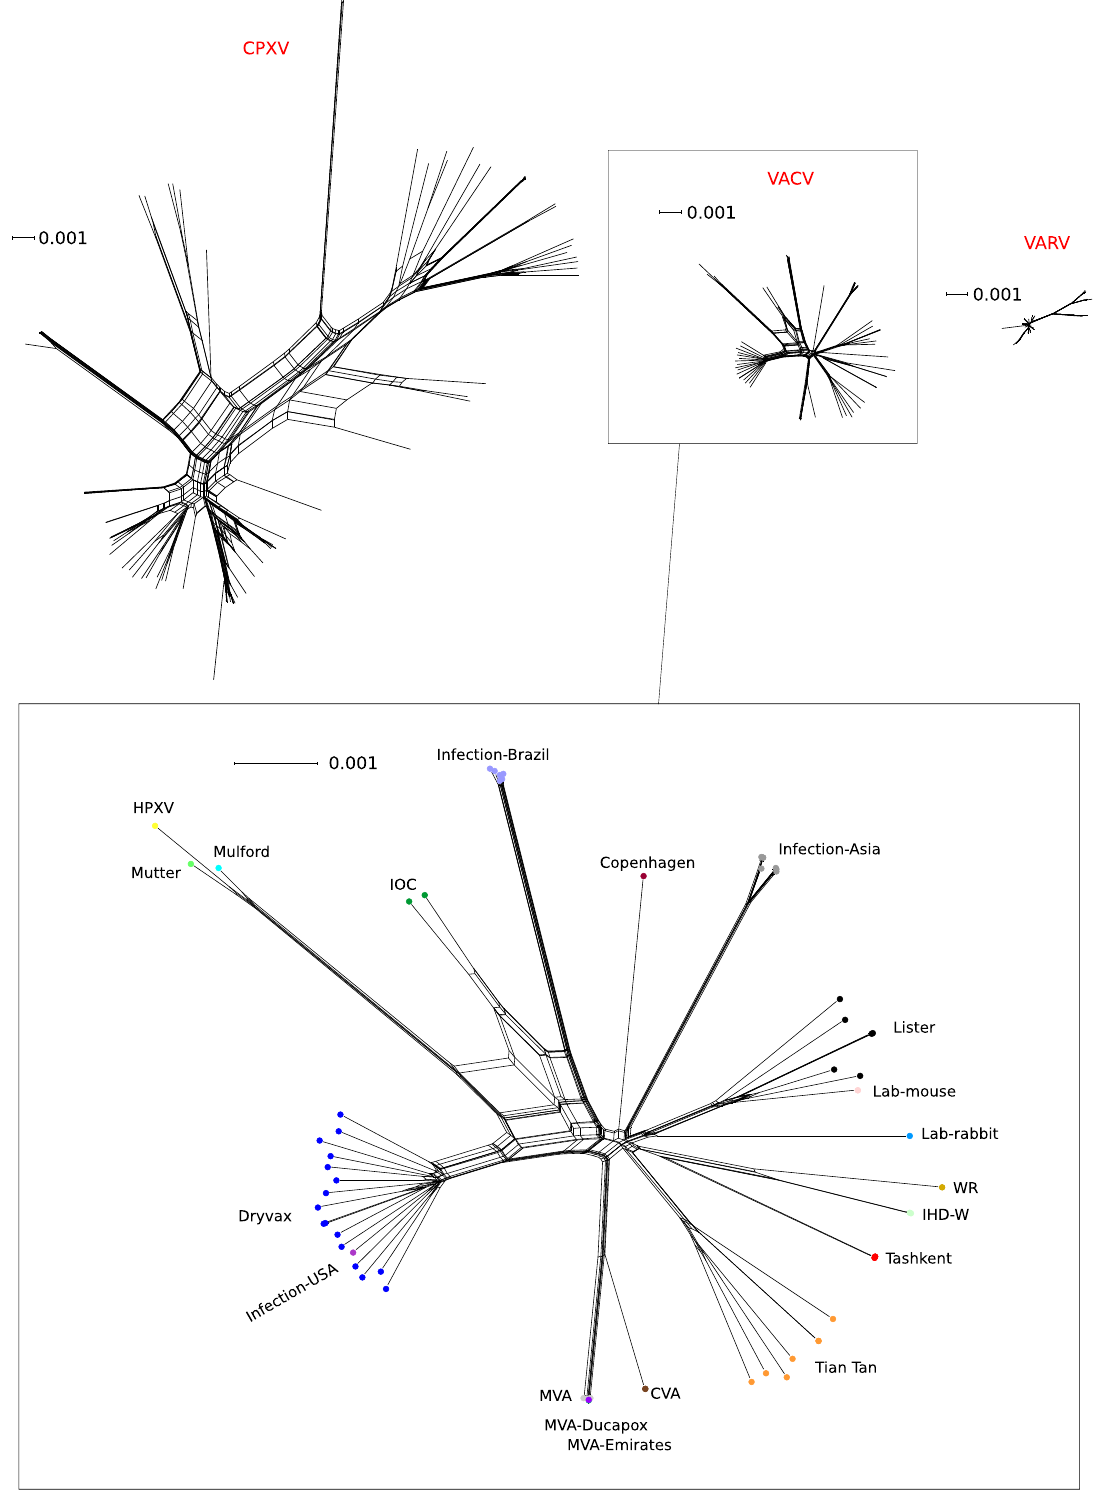
Fig. 1 Genetic variability within different orthopoxvirus species. Neighbor-net split network of 90 CPXV, 50 VARV, and 64 VACV genome sequences; the three networks are plotted at the same scale (expressed as substitutions/site). An enlargement of VACV genomes is also provided, with samples shown as dots and colors representing group